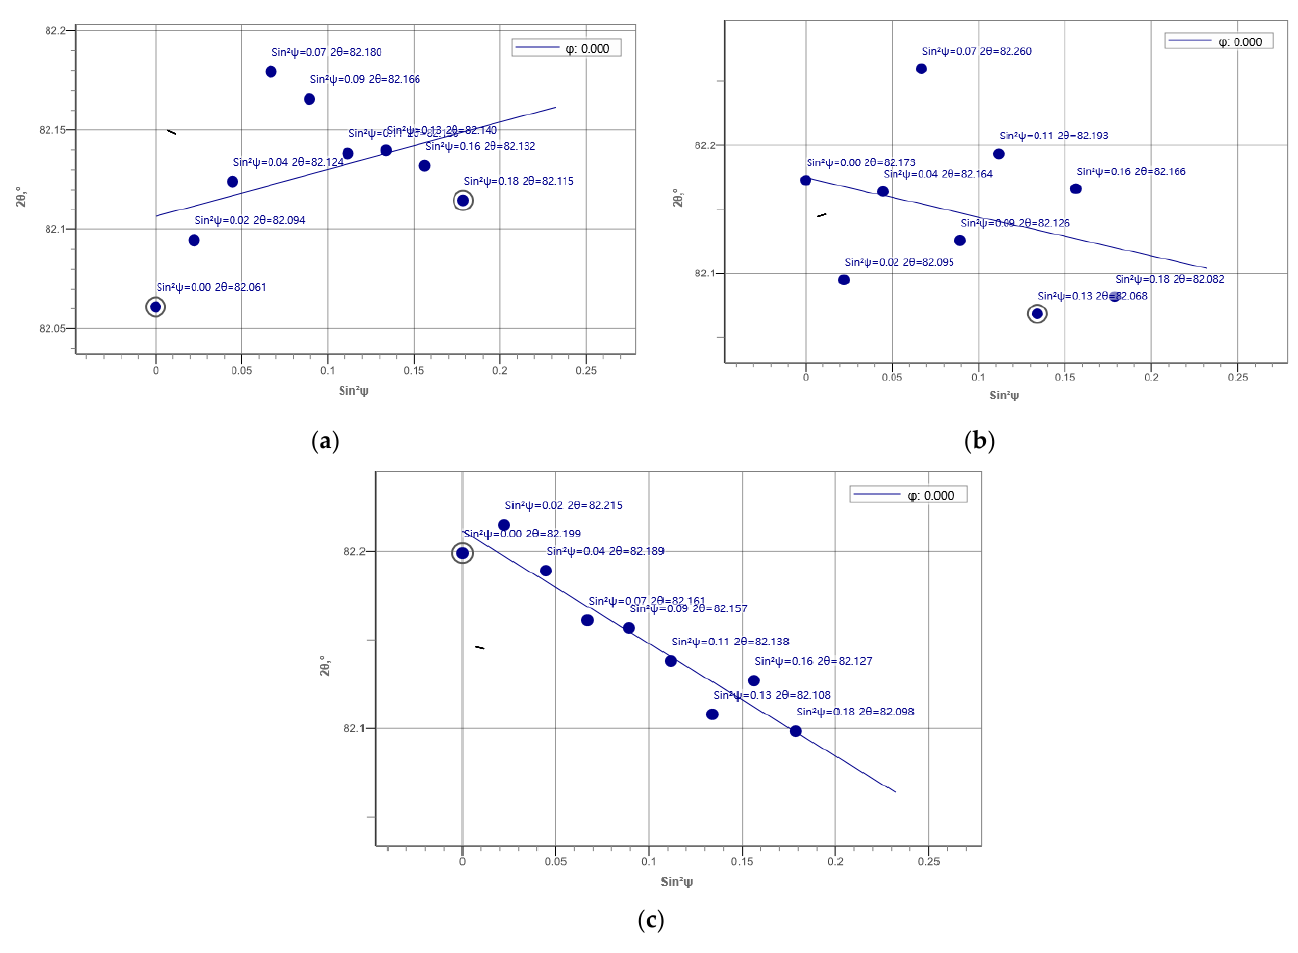
Figure 13. Residual stress diagrams of the overlap-defect specimen. ( a ) Heat-affected zone; ( b ) Upper region of the bead; ( c ) Middle region of the bead.